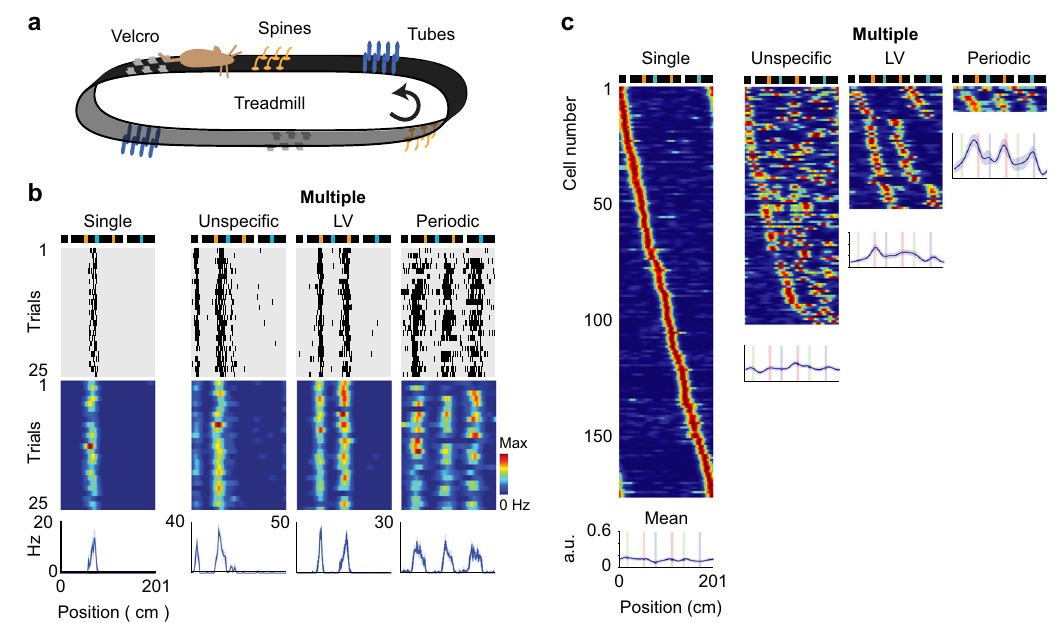
Fig. 2 Types of place fi eld activity among GCs. a Scheme of the treadmill showing the 3 pairs of landmarks fi xed on the belt. b Individual cell examples for various types of GC representations: a single- fi eld cell; a landmark-vector (LV) cell (showing two fi elds matching a type of landmark); a periodic cell (with three periodic fi elds); and an unspeci fi c cell (with more than one fi eld that are neither LV nor periodic). Top, scheme of the belt; middle, spike raster and color-coded fi ring rate map; bottom, mean fi ring rate. c Color-coded, fi ring rate maps of GCs from all sessions, sorted according to fi eld positions and grouped by type of representation. Line plots, average of fi ring rate maps for each type of representation (lines, the mean; shadows, s.e.m; n = 178 single, 105 unspeci fi c, 53 LV and 11 periodic cells). The color scale is the same as that used in ( b ).